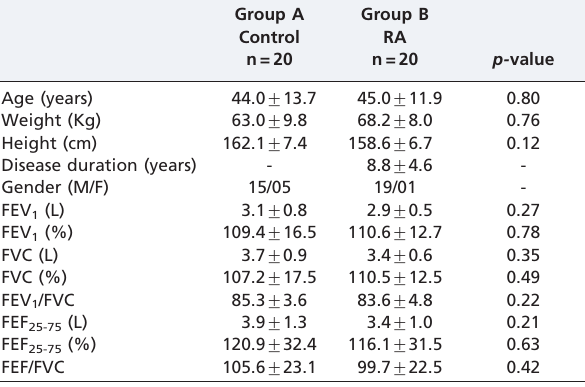
Figure 1 - Mean curves of Rrs (A) and Xrs (B) as a function of frequency in normal (blue) and AR (red)